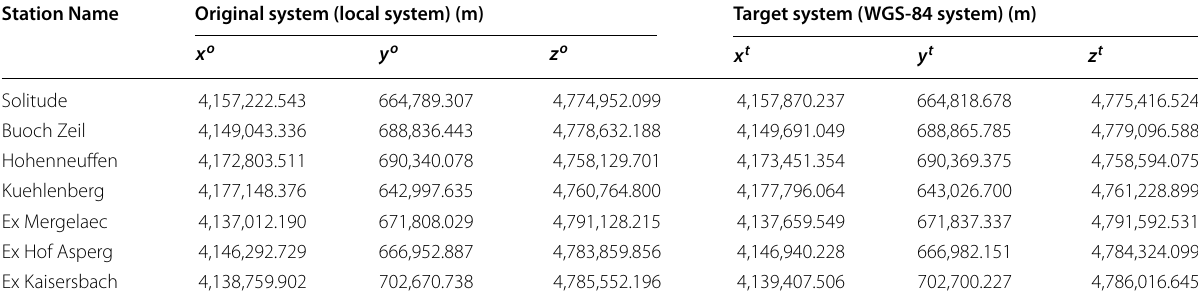
Table 2 3D coordinates of control points